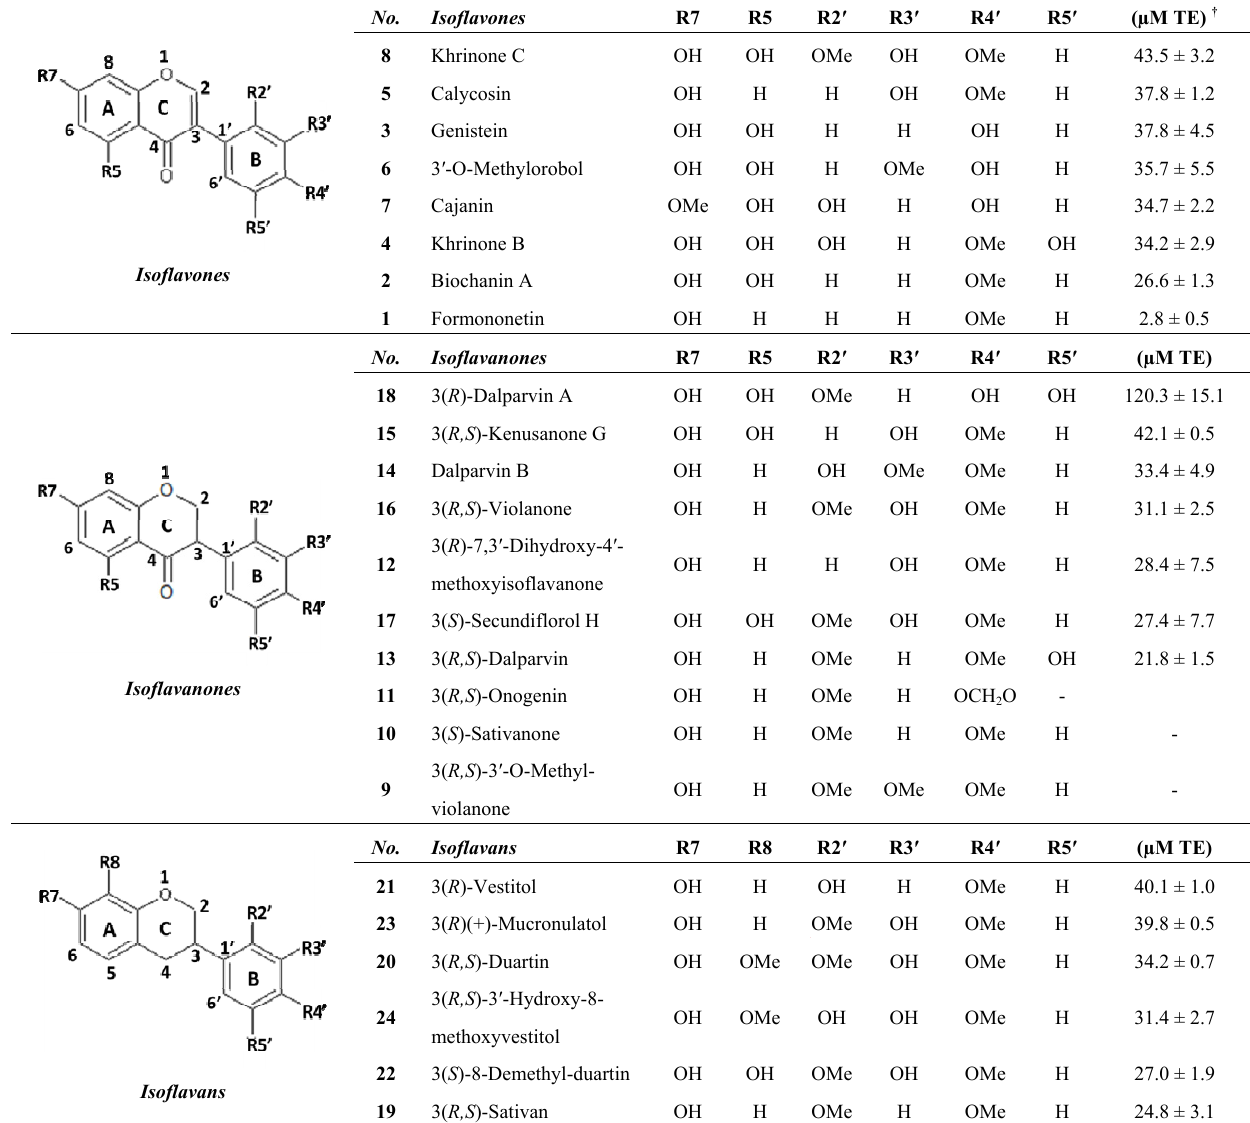
Table 3. SAR of D. parviflora isoflavonoids based on the ORAC assay.